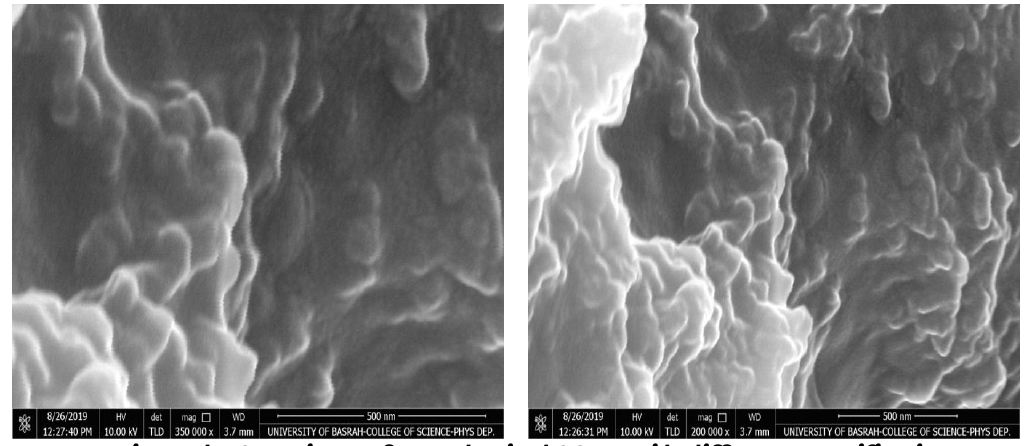
Fig.5: The SEM image for synthesized CQDs with different magnification.